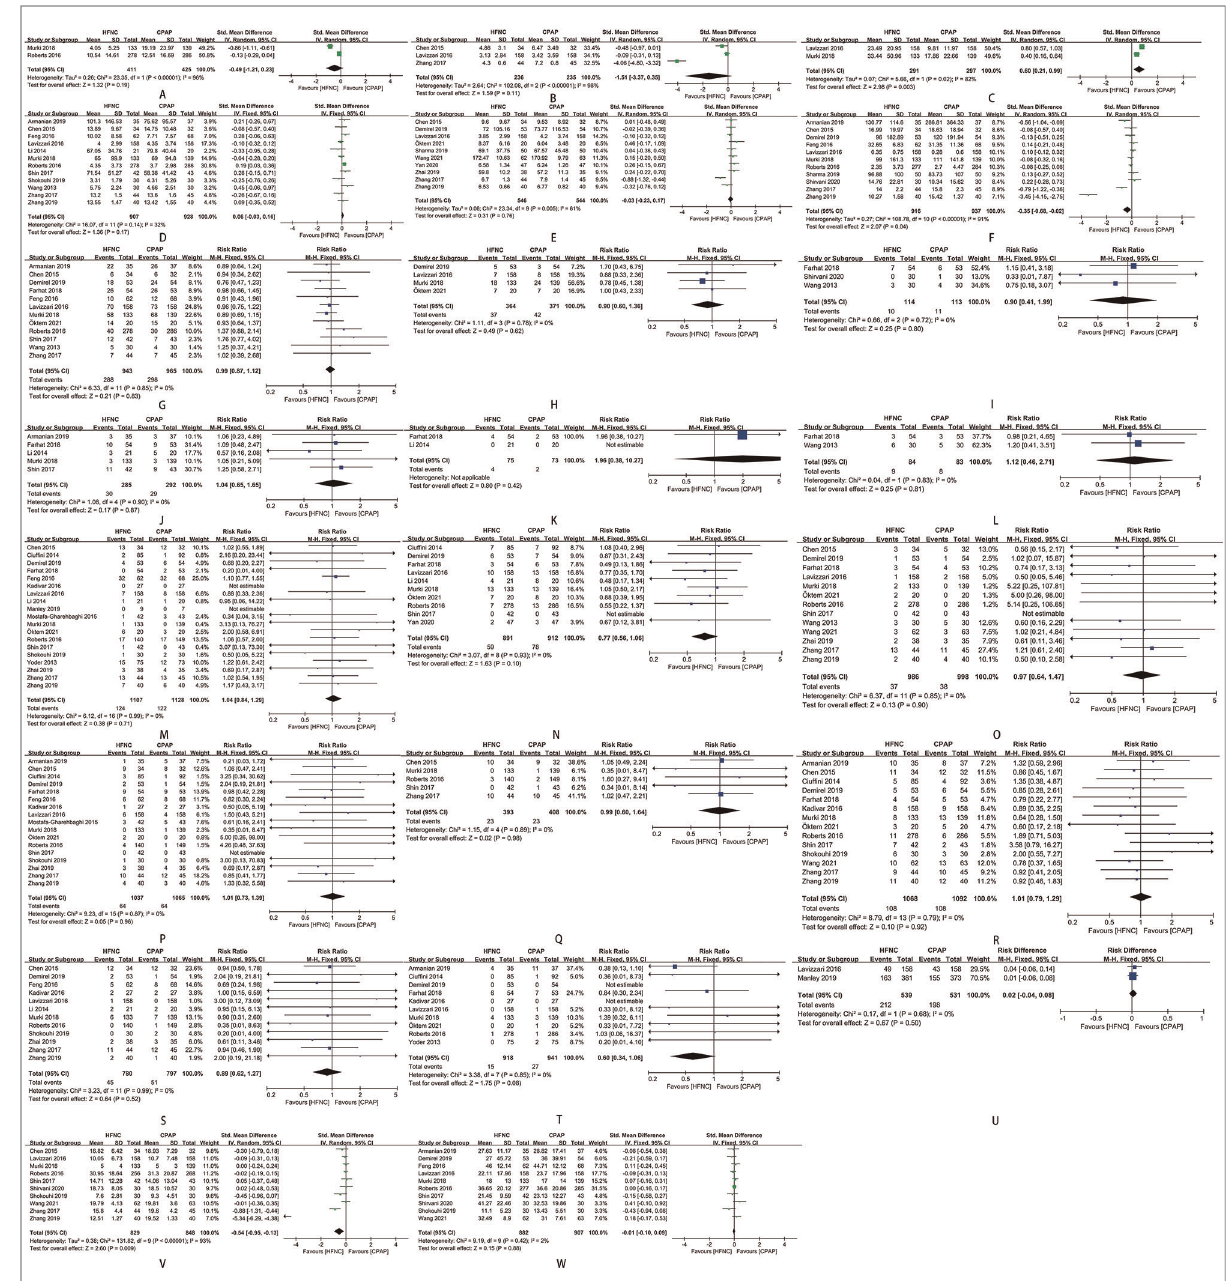
FIGURE 7 ( A ) forest plot of comparison: HFNC vs. CPAP-age-respiratory failure onset. ( B ) Forest plot of comparison: HFNC vs. CPAP-duration-Mechanical ventilation. ( C ) Forest plot of comparison: HFNC vs. CPAP-age-Mechanical ventilation initiating. ( D ) Forest plot of comparison: HFNC vs. CPAP- duration-Respiratory support. ( E ) Forest plot of comparison: HFNC vs. CPAP-duration-Non-invasive respiratory support. ( F ) Forest plot of comparison: HFNC vs. CPAP-duration-Oxygen therapy. ( G ) Forest plot of comparison: HFNC vs. CPAP-number-Surfactant. ( H ) Forest plot of comparison: HFNC vs. CPAP-number-Surfactant with multiple doses. ( I ) Forest plot of comparison: HFNC vs. CPAP-number-Hypercapnia. ( J ) Forest plot of comparison: HFNC vs. CPAP-number-Apnea. ( K ) Forest plot of comparison: HFNC vs. CPAP-number-Pulmonary hemorrhage. ( L ) Forest plot of comparison: HFNC vs. CPAP-number-Pneumonia. ( M ) Forest plot of comparison: HFNC vs. CPAP-number-Bronchopulmonary dysplasia. ( N ) Forest plot of comparison: HFNC vs. CPAP-number-Sepsis. ( O ) Forest plot of comparison: HFNC vs. CPAP-number-Necrotizing enterocolitis. ( P ) Forest plot of comparison: HFNC vs. CPAP-number-Intraventricular hemorrhage. ( Q ) Forest plot of comparison: HFNC vs. CPAP-number-Periventricular leukomalacia. ( R ) Forest plot of comparison: HFNC vs. CPAP-number-Patent ductus arteriosus. ( S ) Forest plot of comparison: HFNC vs. CPAP-number-Retinopathy of prematurity. ( T ) Forest plot of comparison: HFNC vs. CPAP-number-Death. ( U ) Forest plot of comparison: HFNC vs. CPAP-number-Exclusive breastfeeding. ( V ) Forest plot of comparison: HFNC vs. CPAP-age-Enteral feeding. ( W ) Forest plot of comparison: HFNC vs. CPAP-length-Hospital